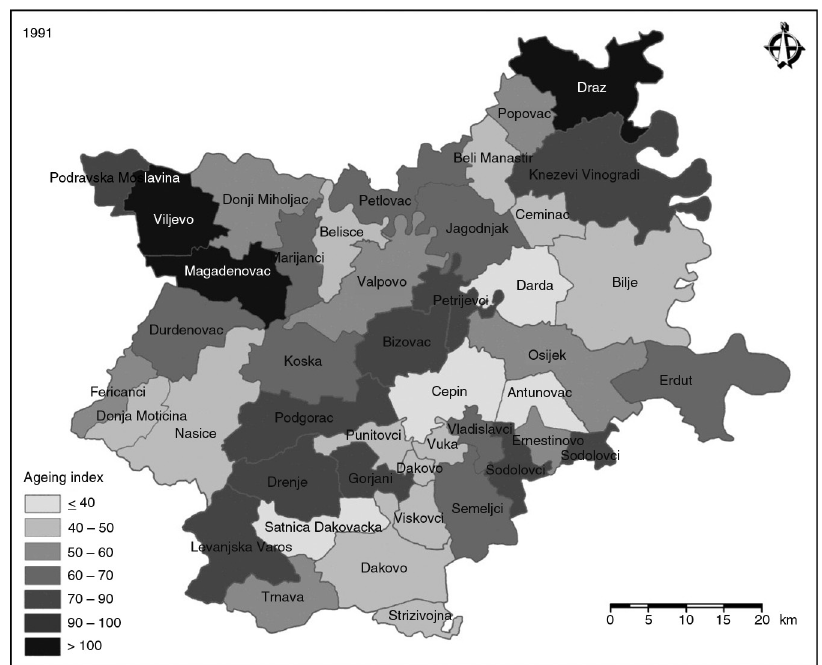
Figure 5. Ageing index of the municipalities in 1991 (pre-war state). Source : CBS